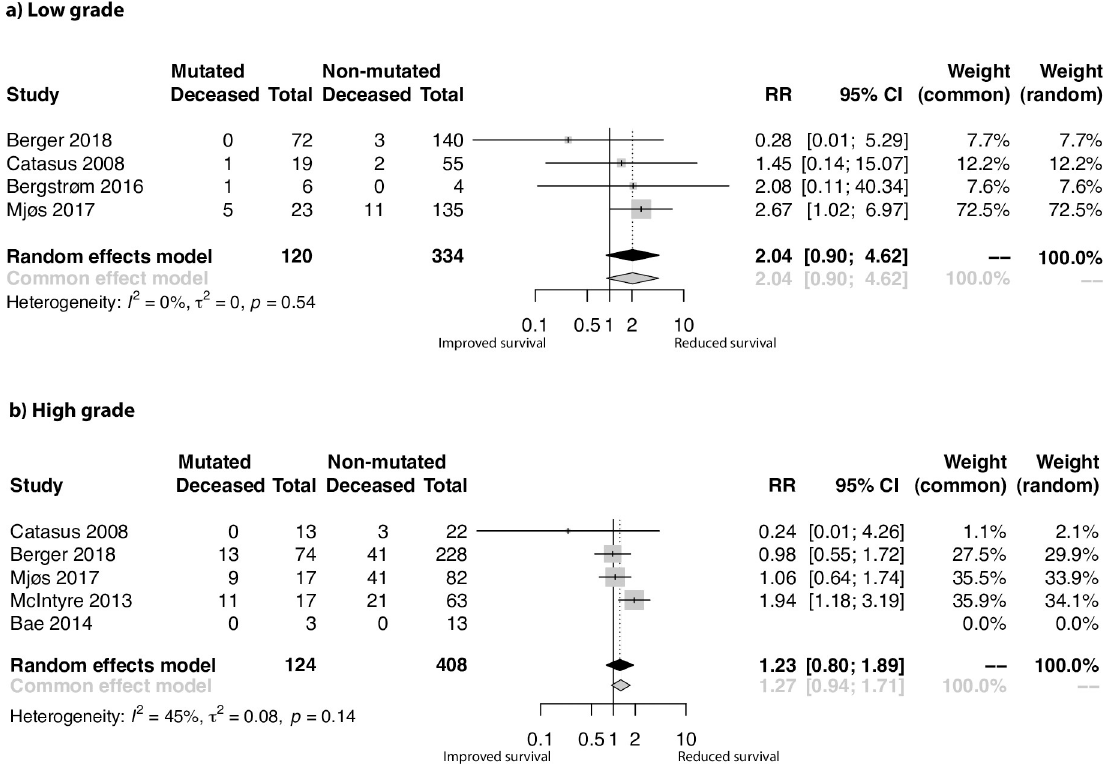
Fig 4. Meta-analysis results of the effect of PIK3CA mutations on EC patient survival in relation to grade. Forest plots visualizing relative risks (RR) of combined overall and disease-specific survival in the a) low-grade and b) high grade subgroups.